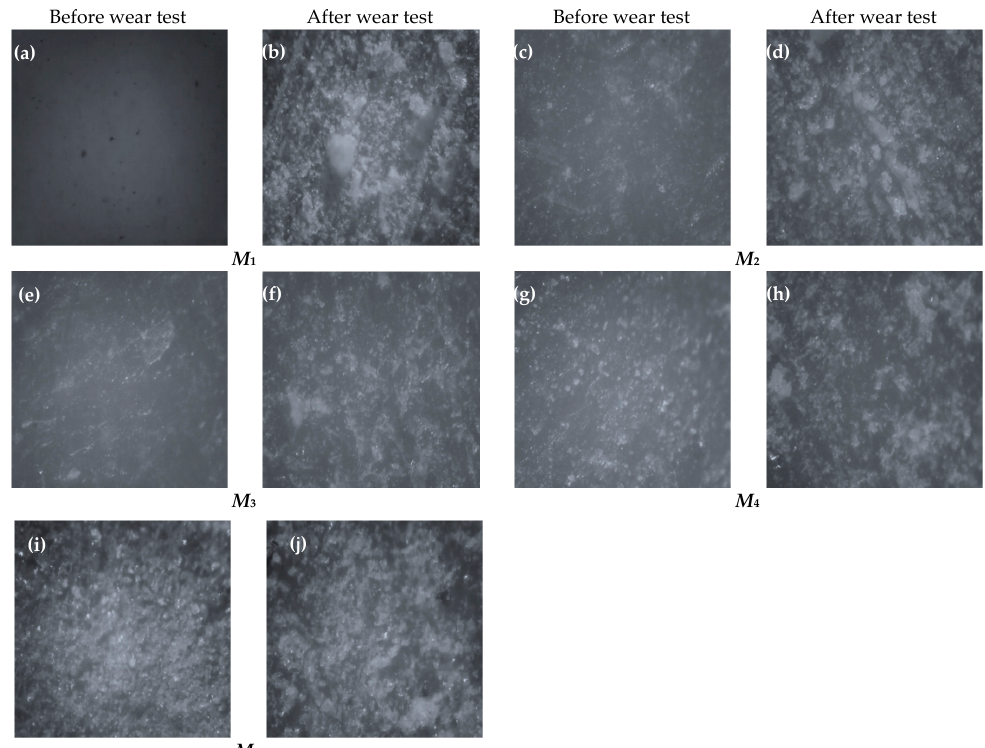
Figure 11. The optical micrographs of the surface of the sample before and after wear tests: ( a , b ) M 1 , ( c , d ) M 2 , ( e ,f) M 3 , ( g , h ) M 4 , and ( i , j ) M 5 . The wear performance of the neat epoxy and FGM composites are influenced by the normal load and sliding velocity as indicated by microscopic images shown in Figures